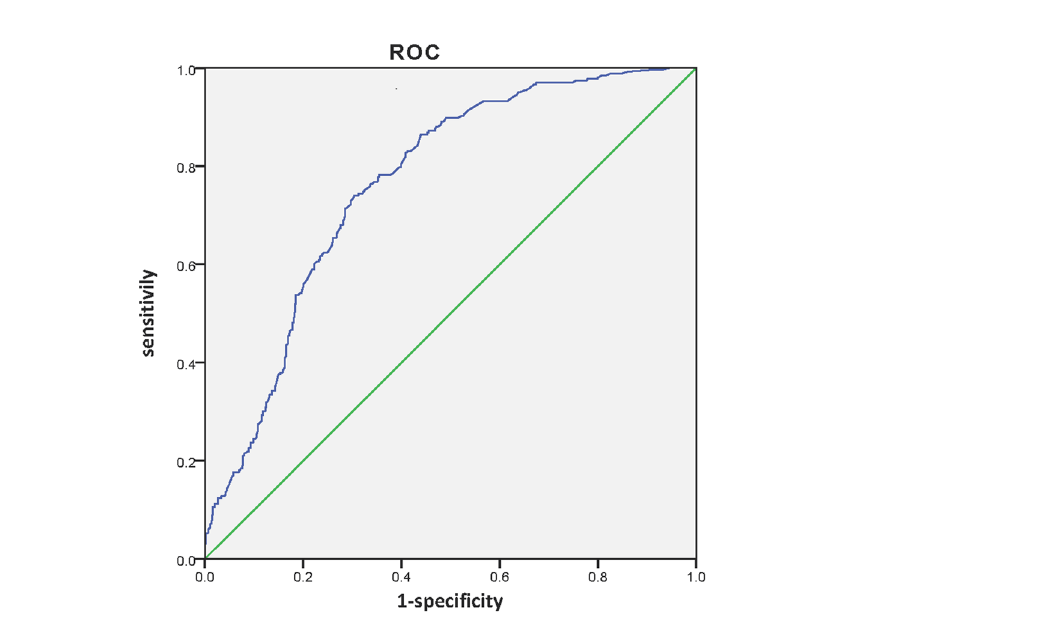
Figure 2. ROC curve in the training cohort. The AUC was 0.764 (95% CI